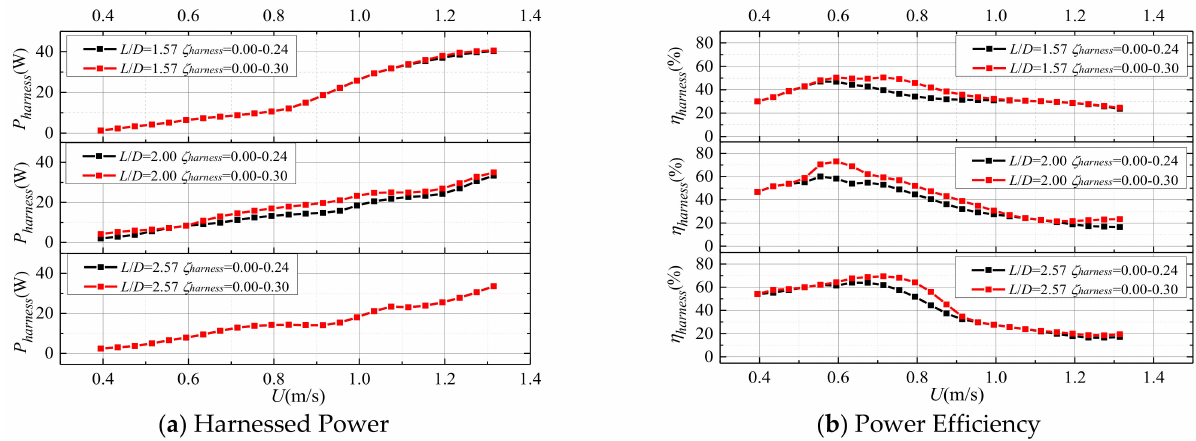
Figure 15. The optimal power and efficiency curves for spacing ratio L / D = 1.57, 2.00 and 2.57: ( a ) Harnessed power; ( b ) Power efficiency. Model is based on K = 400–1200 N/m and 0.00 < ζ harness <